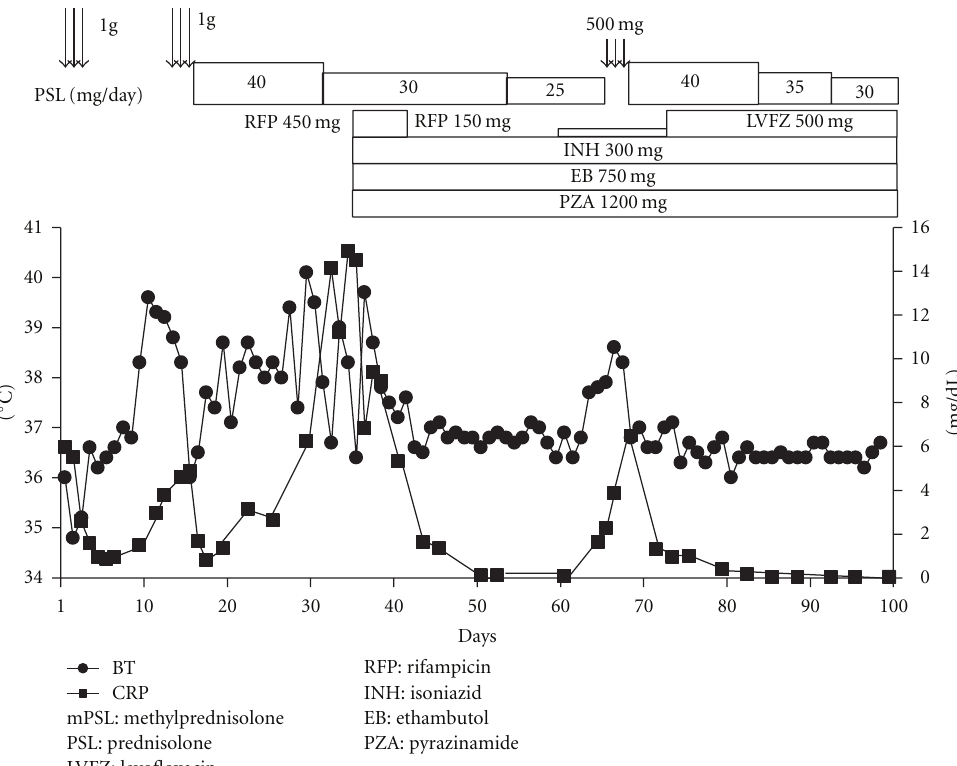
Figure 3: Clinical course after